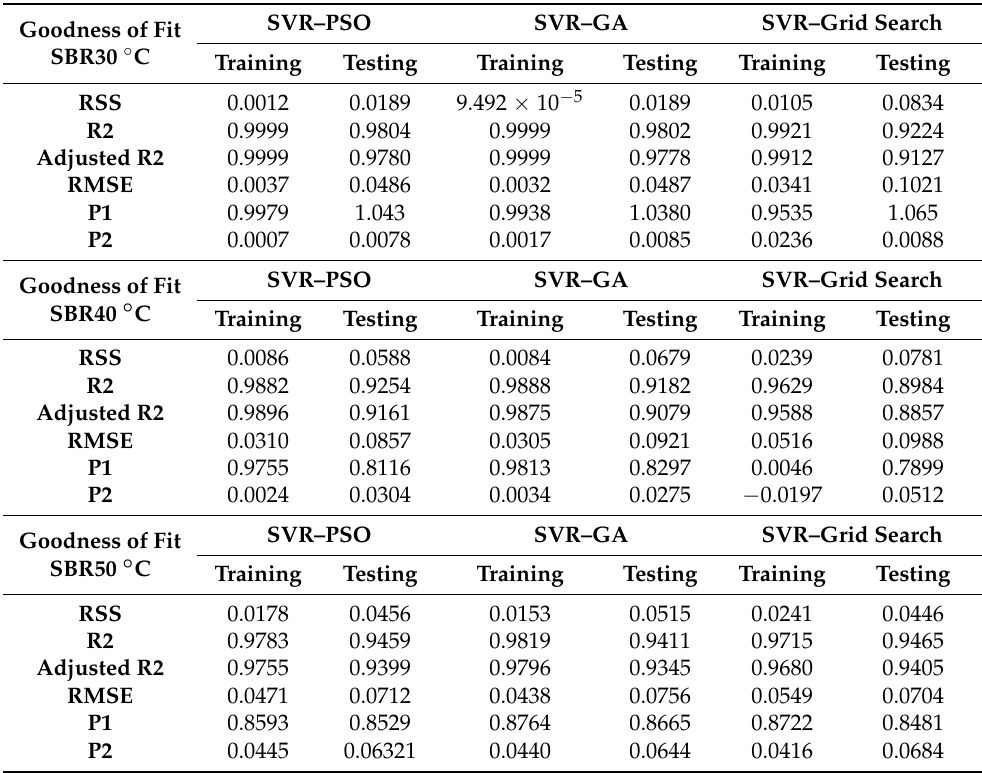
Table 7. Goodness of fit for each